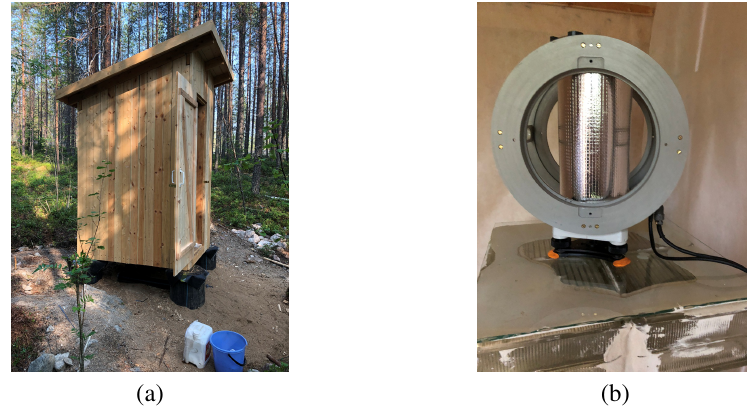
Figure 14. Magnetometer POS-4 at the White Sea Magnetic Observatory (WSE) of the GC RAS: (a) the view of the non-magnetic pavilion (under construction), (b) the POS-4 sensor on a pillar (http: // geomag.gcras.ru /